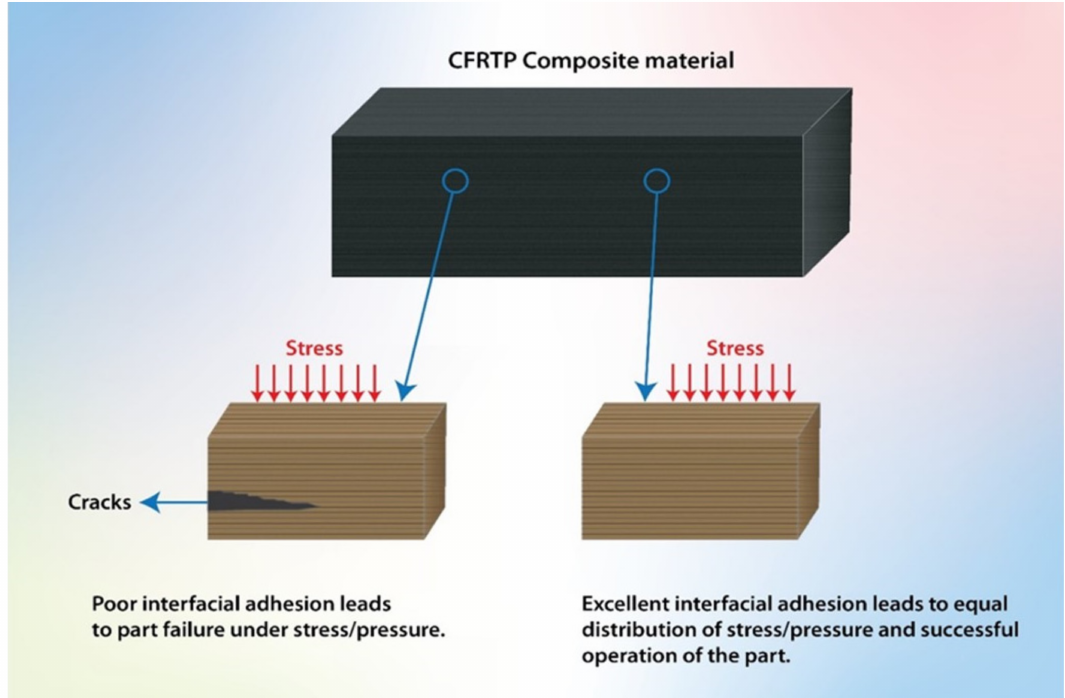
Figure 3. Schematic diagram of poor and excellent interfacial adhesion between the polymer matrix and the